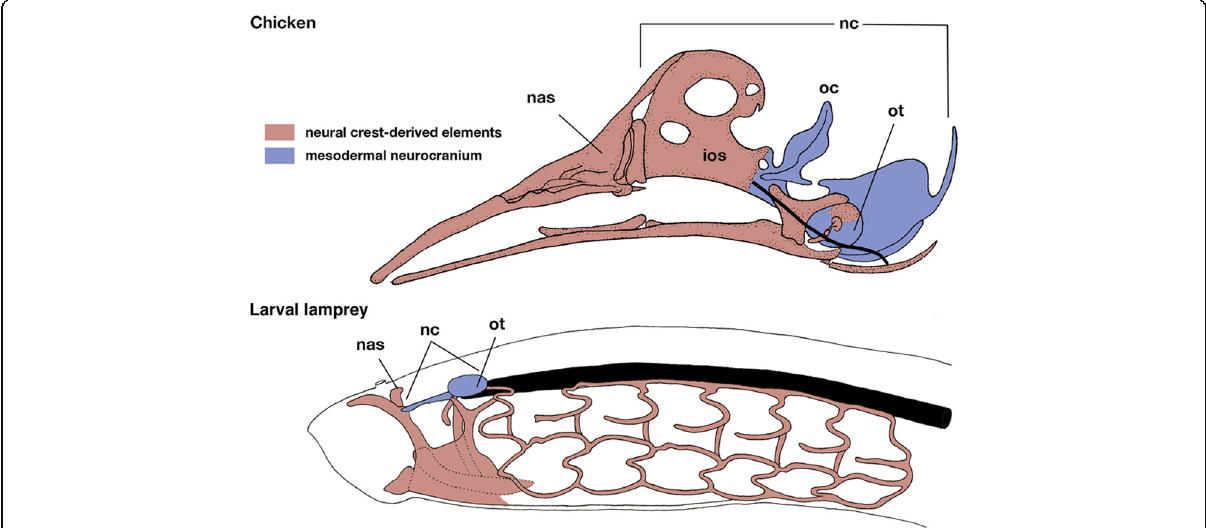
Fig. 3 Comparison of ectomesenchyme-mesoderm distribution in the cranium between the crown gnathostome (chicken; based on the description by Couly et al., 1993) and the lamprey larva. Modified from reference [24]. Crest-derived cells are shown in red, mesodermal cells in blue. Notochord is represented by thick black lines. Note that the chordal cranium is coextensive with the notochord. In the chicken, the prechordal cranium is represented by the interorbital septum, whereas in the lamprey, the ectomesenchymal cranium is exclusively oro-pharyngeal, and the